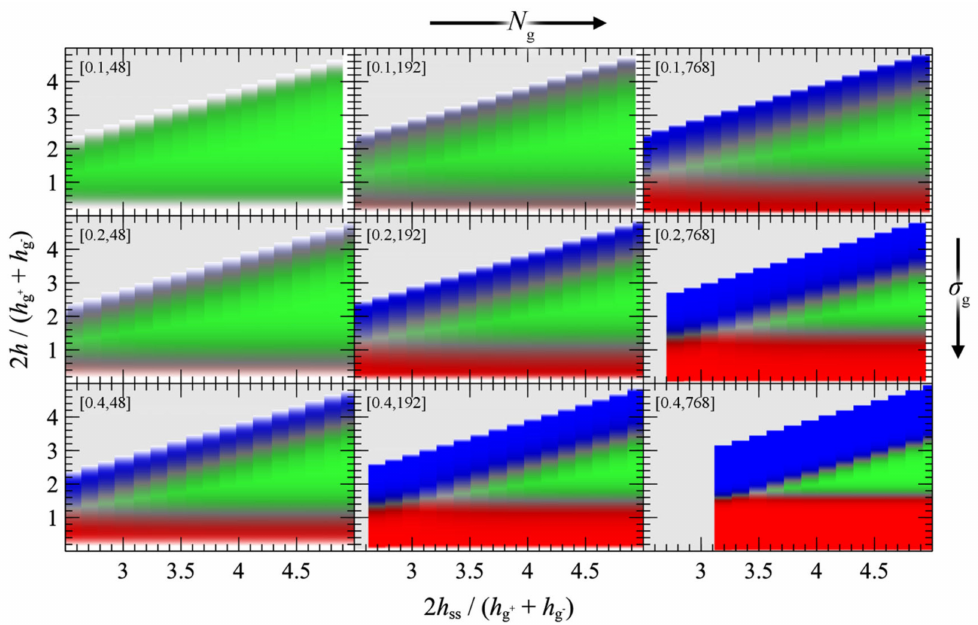
Figure 8. Reduced density distributions corresponding to the PMF GMG panels in Figure 7 , as a function of the plate-plate distance (abscissa) and the distance from the left wall (ordinate) in reduced units. Red/green/blue colors correspond to regions with high density ( ϕ c = 1) of c = g − /m/g + chains, respectively. Grey denotes regions which lie outside the modeled domain or have not been evaluated at all. Labels in brackets denote σ g (nm − 2 ) and N g